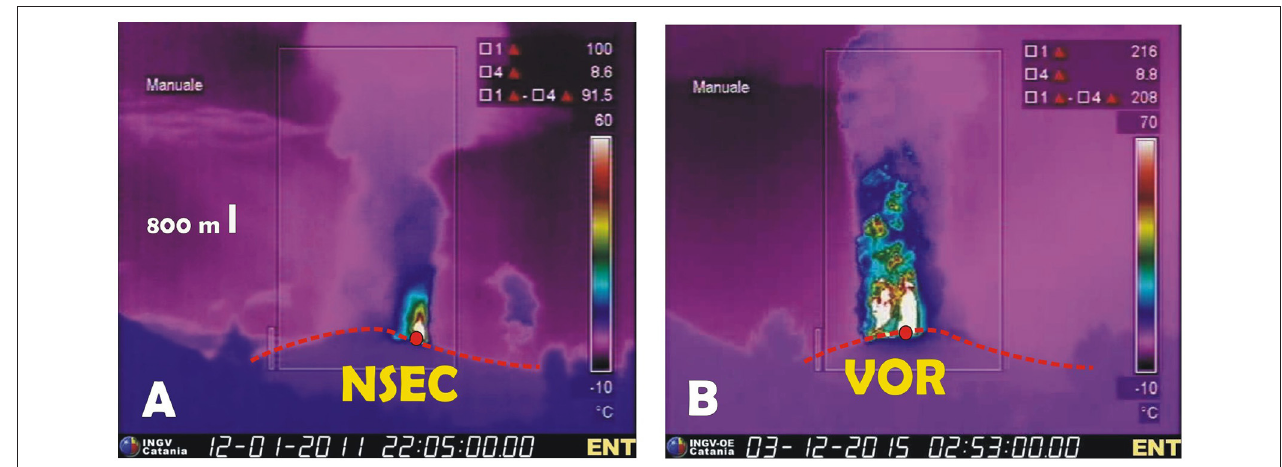
FIGURE 3 | Thermal images from the camera located at Nicolosi, showing (A) the first lava fountain episode from NSEC, occurring on 12 January 2011 and taken at 22:05 UT, and (B) the first lava fountain episode from VOR on 3 December 2015 and taken at 02:53 UT. The red circles show the position of vent, and the red dotted line is the volcano profile. The white vertical bar in A is for scale. The lava fountain portion is in white-red, the ash plume in bluish-pink. Note the different size of the two episodes, with the VOR lava fountain and plume being much taller and